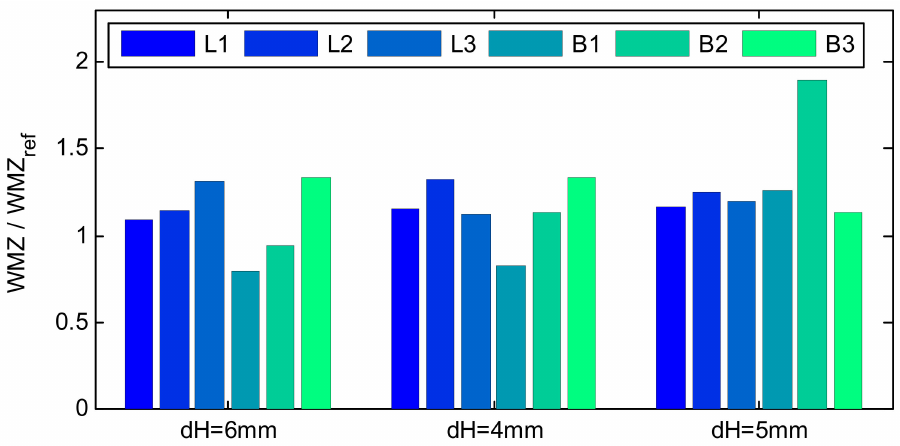
Figure 9. Experimental width of the mixing zone ratios ( WMZ/WMZ ref ) for comparison of heteroge- neous cases to the homogeneous reference case for dH = 6 mm, 4 mm, and 5